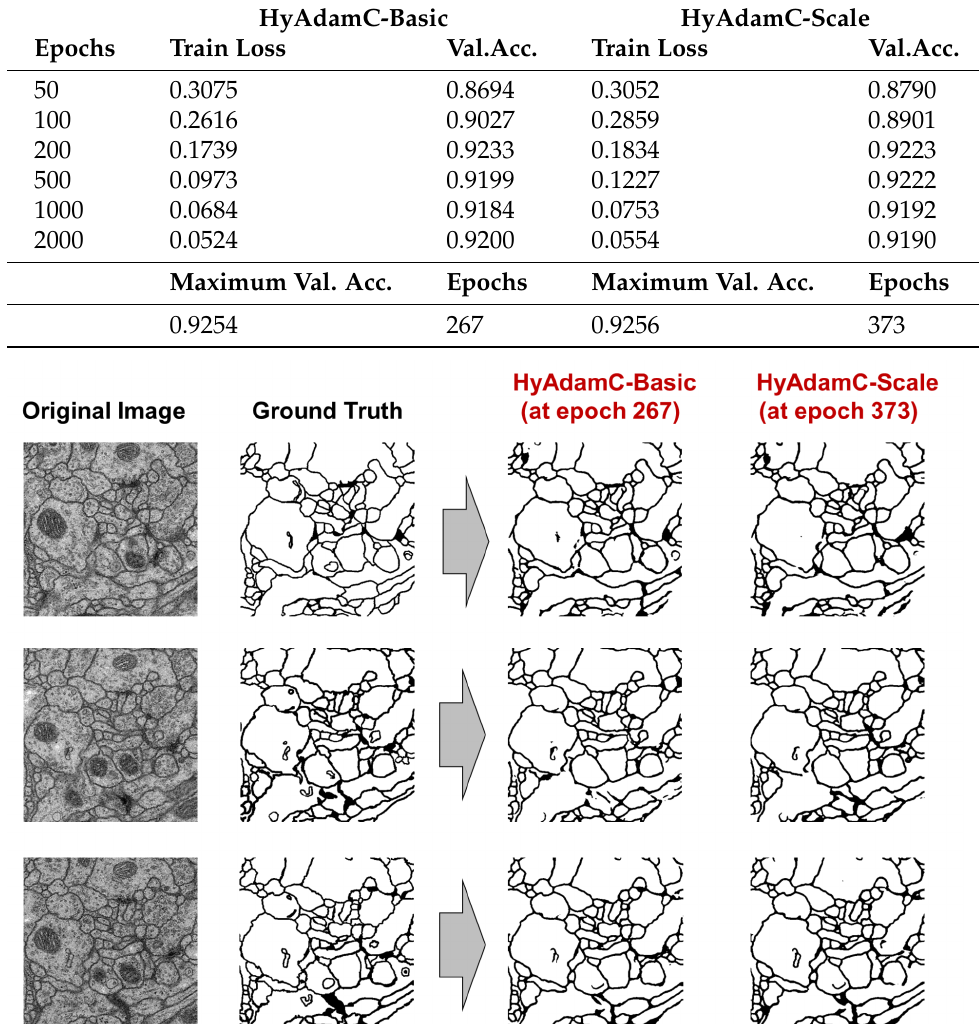
Table 10. The detailed training losses and validation accuracies of HyAdamC-Basic and HyAdamC-Scale.